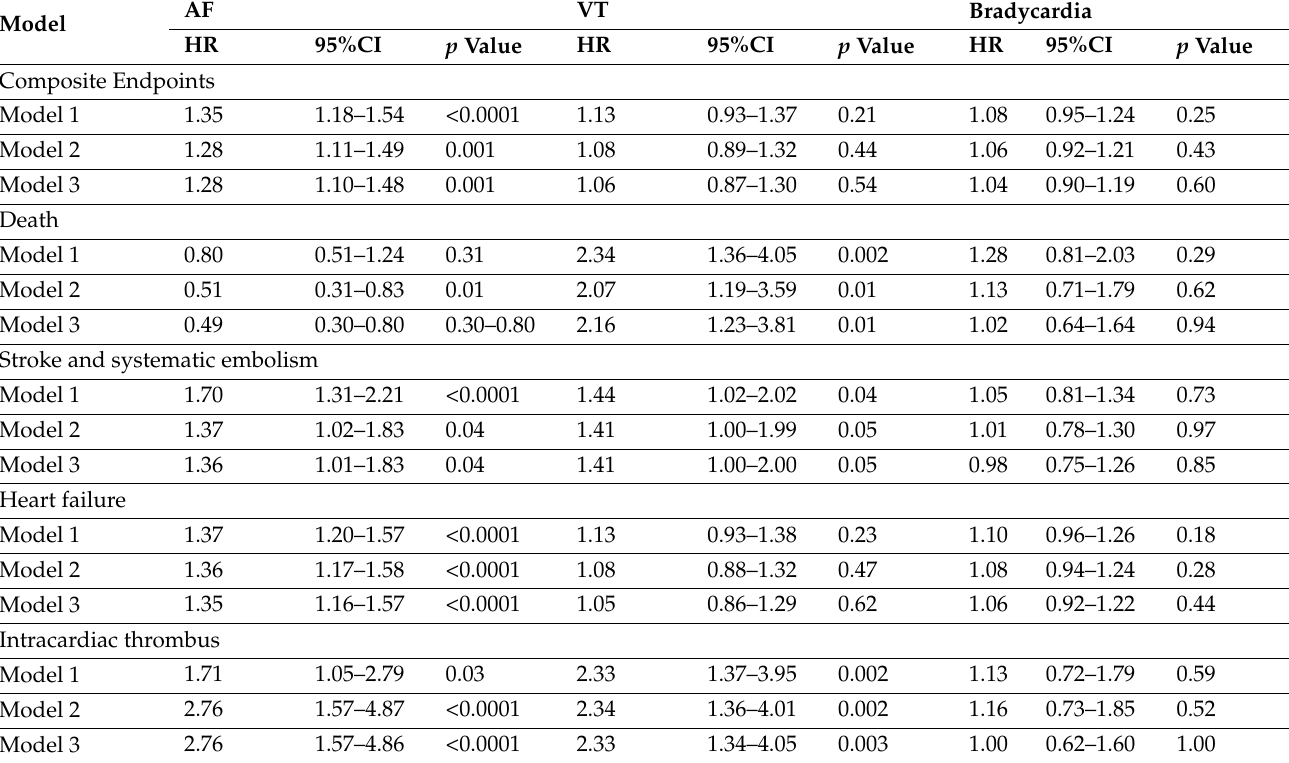
Table 2. Risk of stroke and systematic embolism in patients with